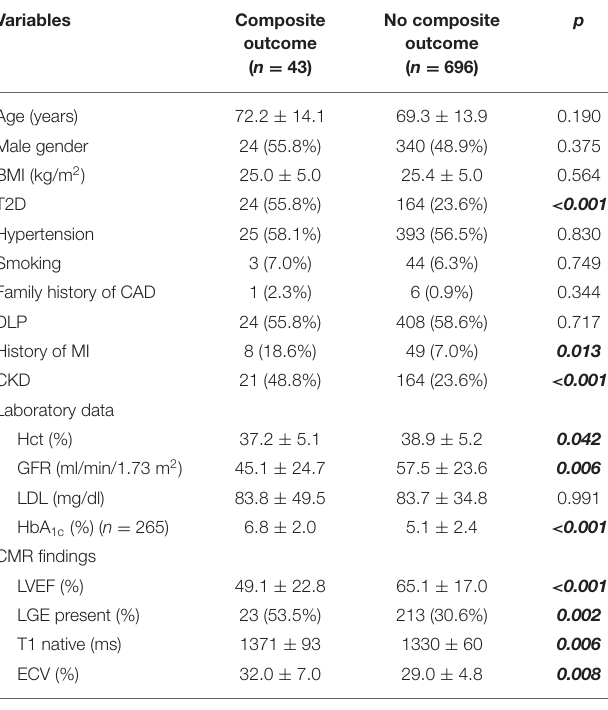
TABLE 3 | Univariate and multivariate analysis for independent predictors of cardiovascular composite outcome. Variables Univariate analysis Multivariate